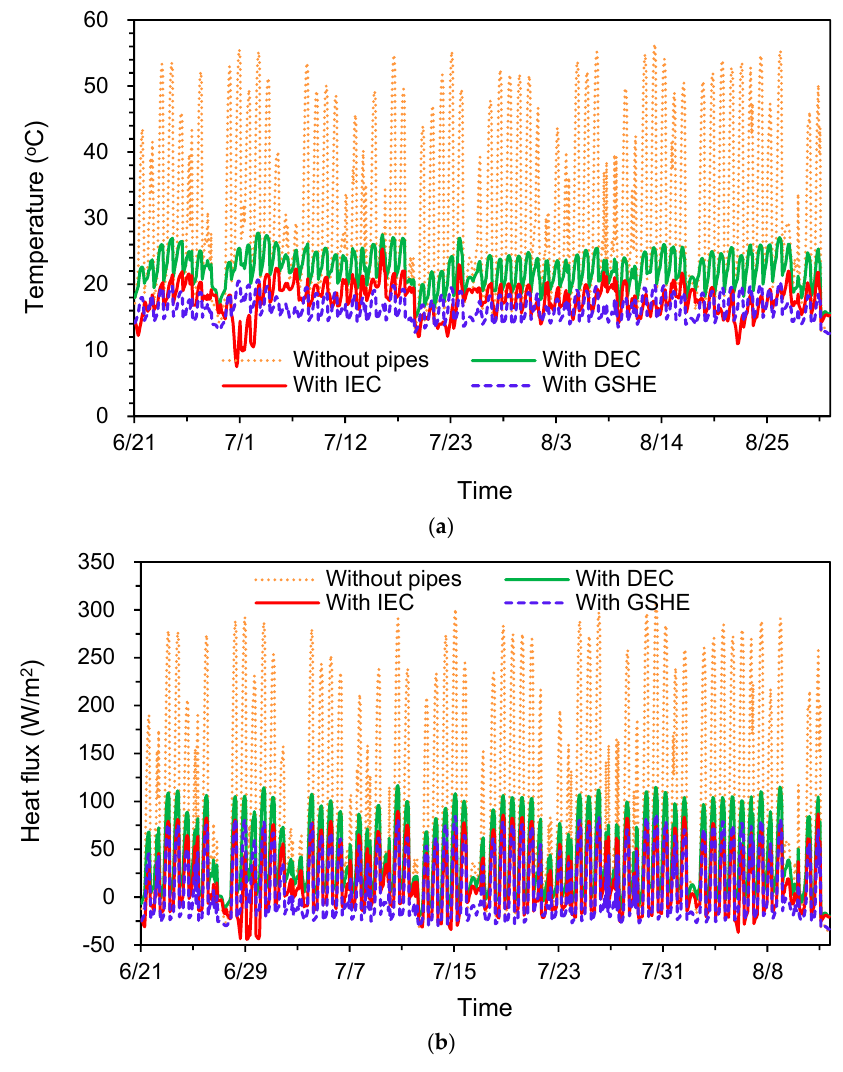
Figure 9. Heat transfer in different windows: ( a ) Temperature variation; and ( b ) Heat flux variation.